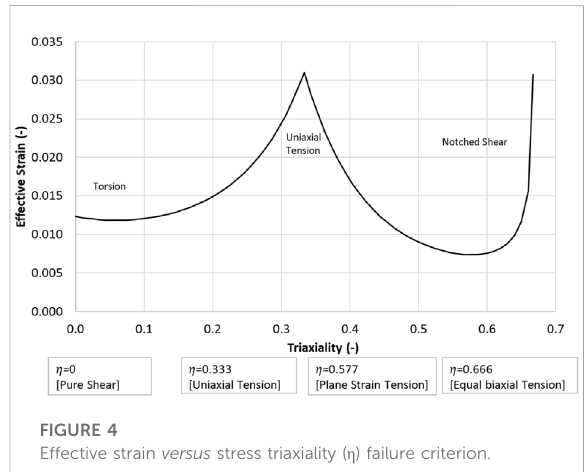
FIGURE 4 Effective strain versus stress triaxiality ( η ) failure criterion.